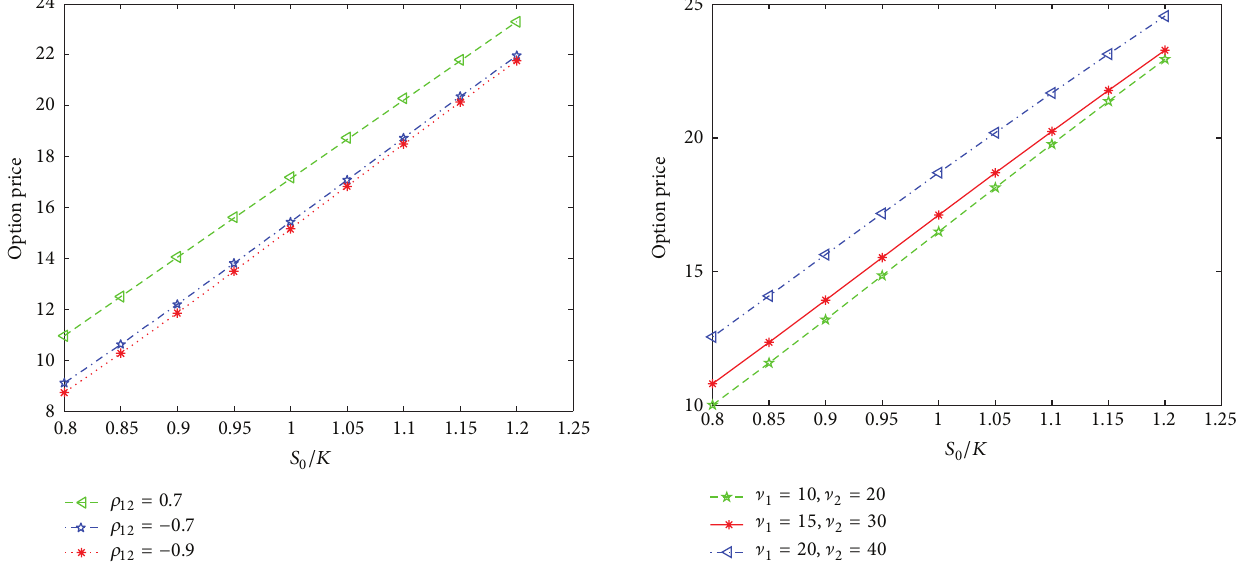
Figure 5: The option price with different ] for 𝜔 = 0.4 , 𝜌 12 = 0.7 , = 0.5 , and 𝜌 = 0.6 . 𝜌 13 23